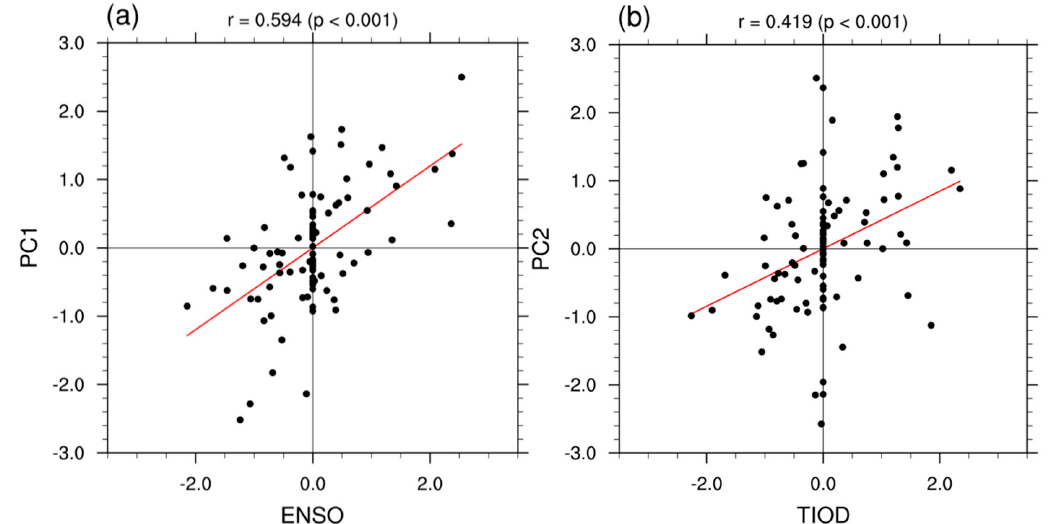
Figure 6. ( a ) Scatterplot of the normalized time series of JJA–mean Niño3.4 index and PC1. ( b ) As in ( a ), but for the JJA–mean TIOD index and PC2. The correlation between the two time series is shown at the top.